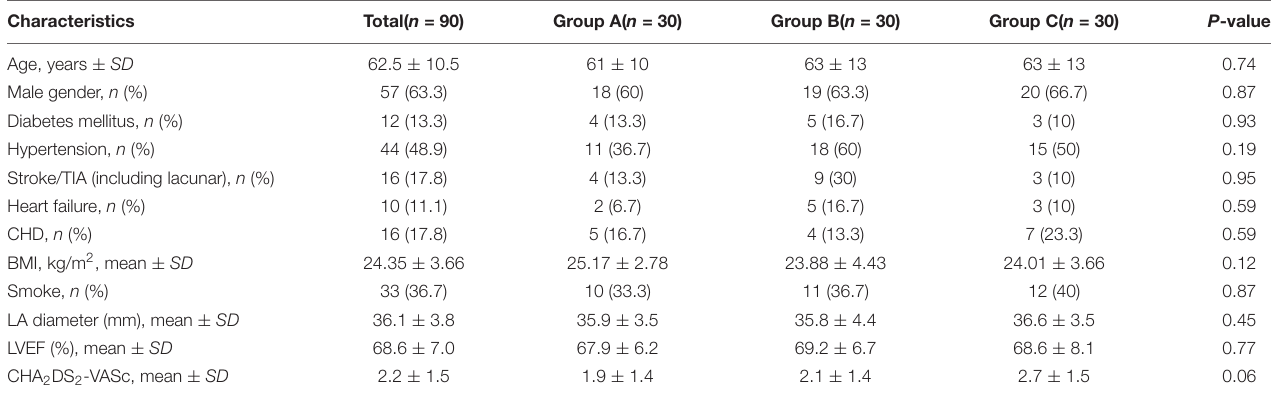
TABLE 1 | Baseline